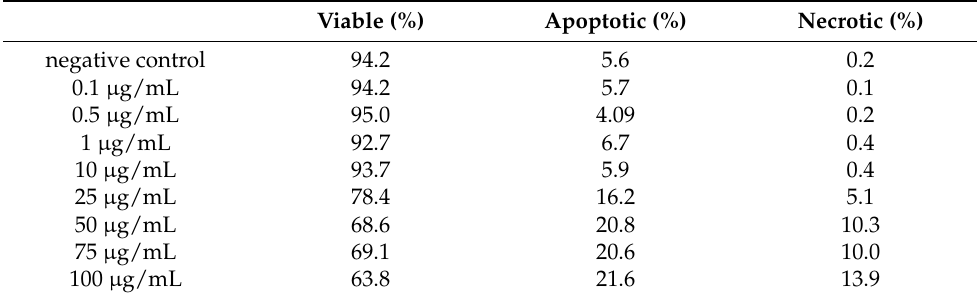
Figure 1. Results of flow cytometric analysis with Annexin-V/Propidiumiodide staining of lymphocytes after treatment with 0.1, 0.5, 1, and 10 µg/mL ZnO-NP for 24 h. The upper left dot-plot shows the untreated reference. Q3 denotes viable cells, Q4 early apoptotic and Q2 late apoptotic/necrotic cells. Data were obtained in one exemplary experiment. There is no notable change in the proportion of viable/apoptotic/necrotic cells after treatment with NP compared to the negative control. APC-A: Allophyocyanin-Annexin-V. Table 1. Results of Annexin-V/Propidiumiodide flow cytometry. Lymphocytes were treated with ZnO-NP between 0.1 and 100 µg/mL for 24 h. Untreated cells served as negative control. Percentages of viable, apoptotic and necrotic cells are illustrated.